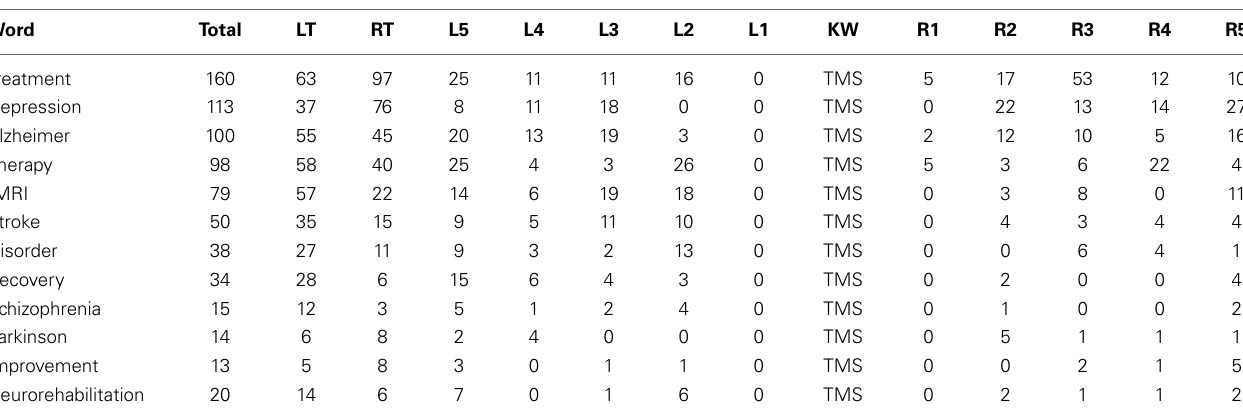
Table 3 | KWIC examples for CR-TMS.